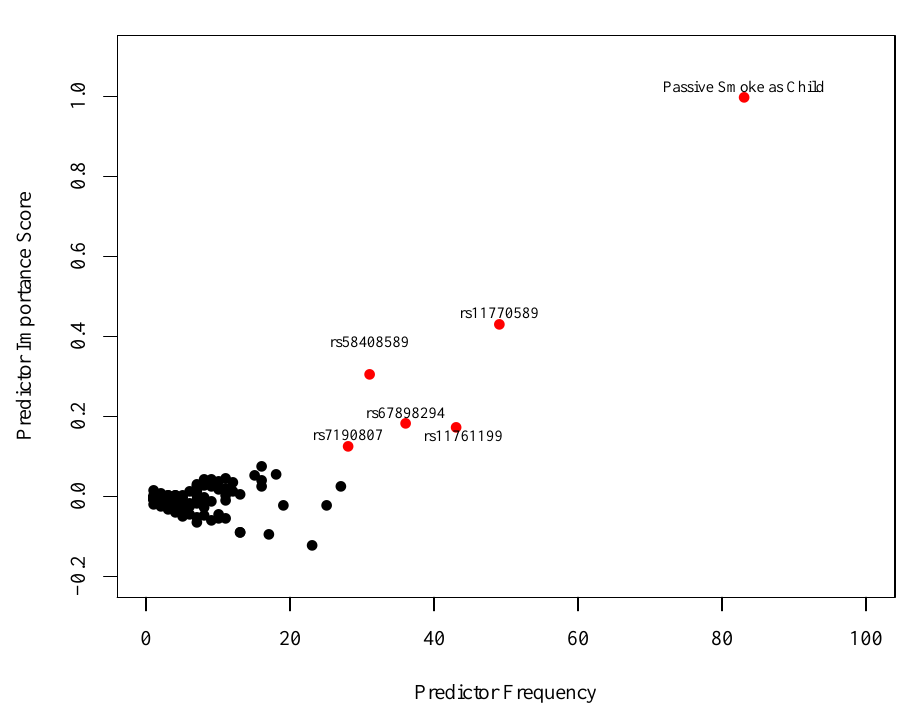
Figure 3. Predictor frequency by normalized predictor importance score for all predictors in the Logic Forest (LF) model. Points highlighted in red represent the predictors that have the largest combination of frequency and importance